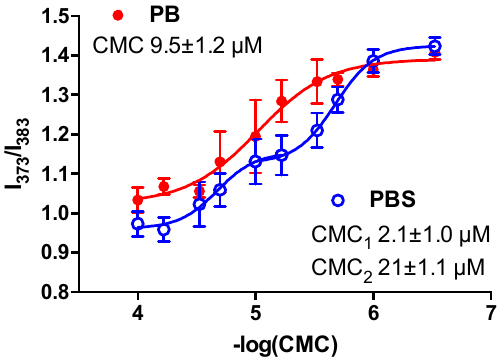
/ I Figure 2. I 373 /I 383 plots corresponding to the amphiphilic dendron association in PB and PBS. Figure 2. I 373 383 plots corresponding to the amphiphilic dendron association in PB and